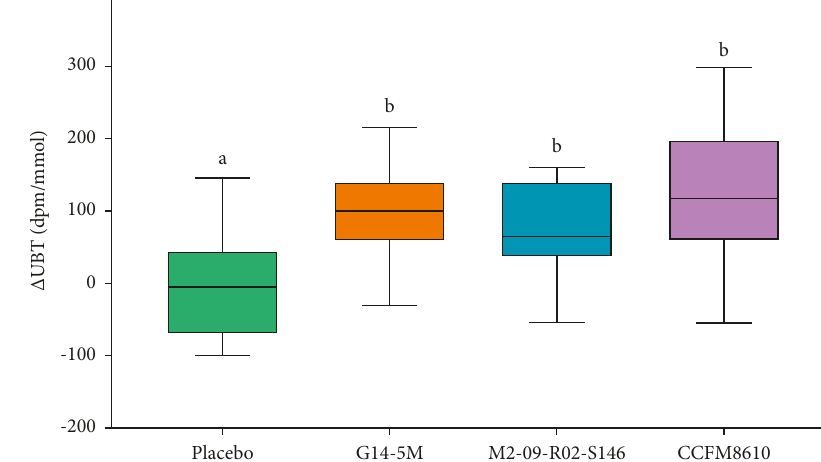
Figure 2: Degree of reduction in 14 C-urea breath test value.